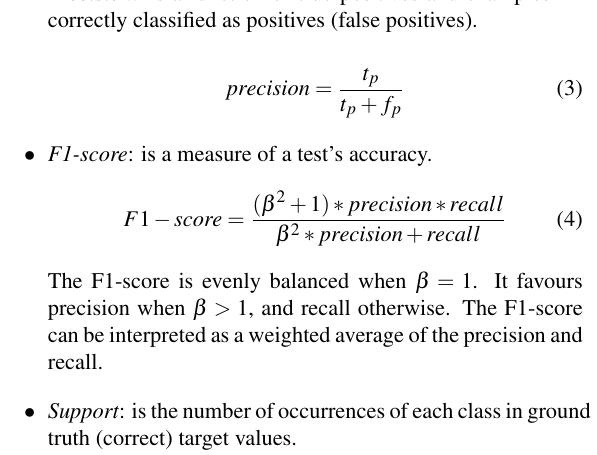
Figure 4. Confusion matrix for ResNet network (learning rate=0.000001, batch=16, epochs=50.